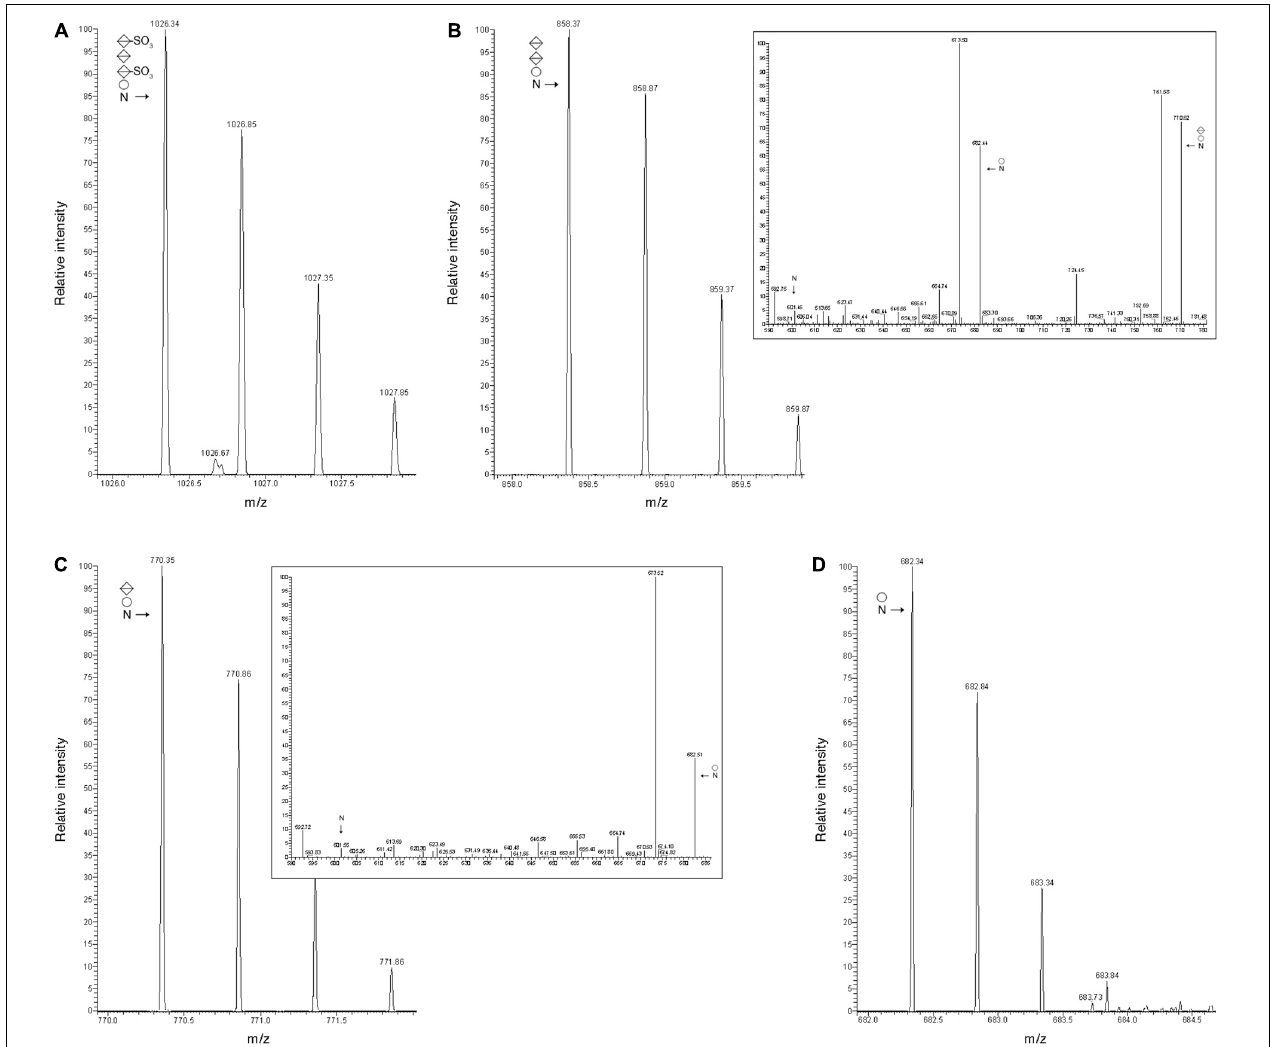
FIGURE 3 | Archaellin N-glycosylation is compromised in cells of the (cid:49) vng1062G , (cid:49) vng1066C , and (cid:49) vng1067G strains. (A) LC-ESI MS profile of the protease-generated peptide QAAGADNINLSK common to the archaellins FlaA1, FlaA2, and FlaB2 in parent strain cells is modified by a tetrasaccharide comprising a hexose, a sulfated hexuronic acid, a hexuronic acid and a sulfated hexuronic acid. (B) In (cid:49) vng1062G strain cells, the same fragment is only modified by the first three sugars of the tetrasaccharide, with no sulfation of the hexuronic acid at position two. The MS/MS profile of this peptide reveals breakdown products corresponding to the same peptide modified by the first two sugars and the first sugar and by no sugars (insert). (C) In (cid:49) vng1066C strain cells, the same fragment is only modified by the first two sugars of the tetrasaccharide, with no sulfation of the hexuronic acid at position two. The MS/MS profile of this peptide reveals breakdown products corresponding to the same peptide modified by the first sugar and by no sugars (insert). (D) In (cid:49) vng1067G strain cells, the same fragment is only modified by the first sugar of the tetrasaccharide. In each panel, circles correspond to hexoses, split diamonds correspond to hexuronic acids and the N corresponds to the Asn-479-containing